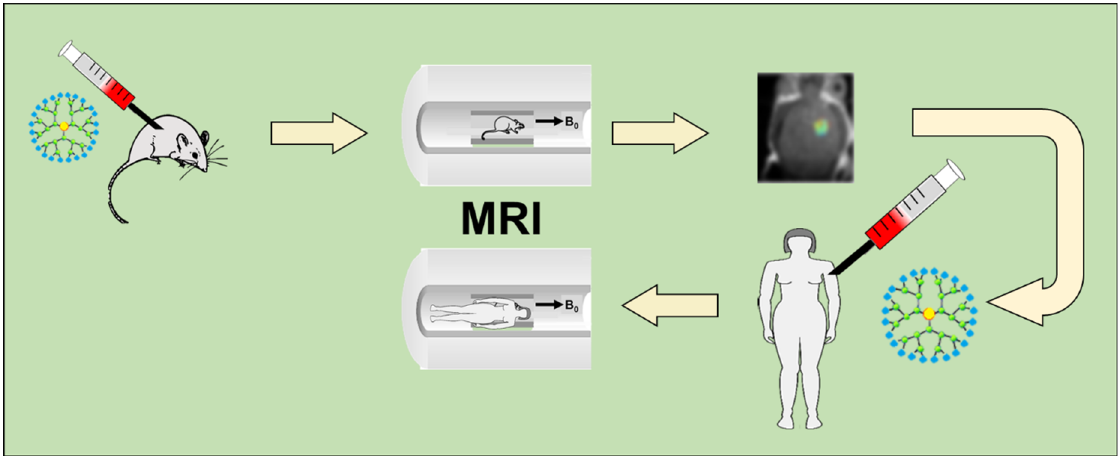
Figure 6. Application of MRI.